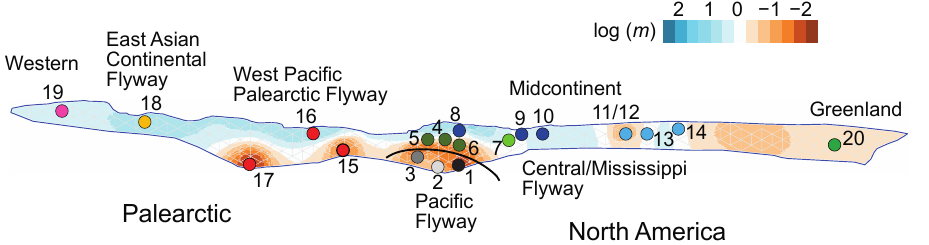
Figure 4. Estimated Effective Migration Surface (EEMS) posterior mean effective gene flow surface (log m). Orange represents areas of low gene flow relative to the average (i.e., barriers) whereas blue denotes areas of higher-than-average gene flow (i.e., connectivity). The colored circles correspond to the clusters identified in the fineRADstructure analysis and the black line separates sampling locations between the two flyways in North America (Figure 3). Map location numbers correspond to location names in Table 1.